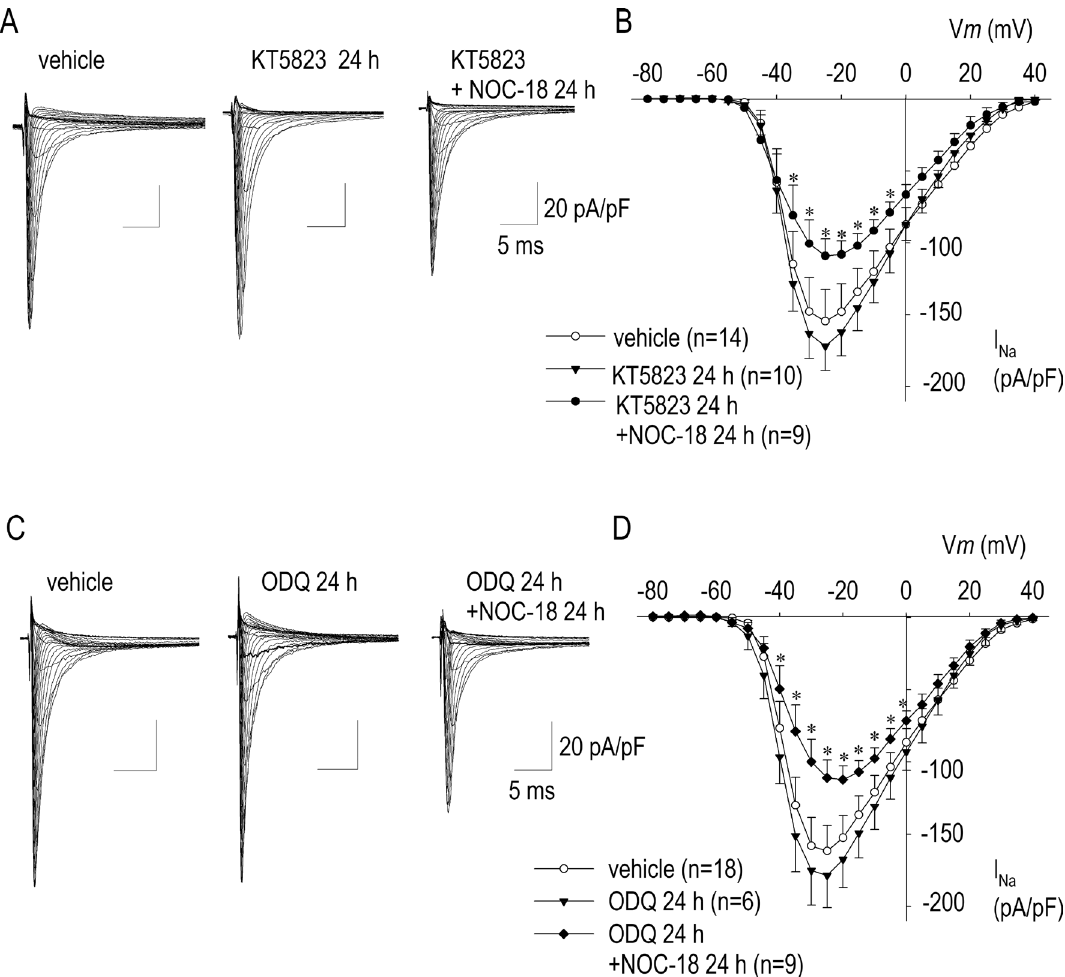
Figure 5. Effects of a PKG inhibitor KT5823 and a guanylate cyclase inhibitor ODQ on NOC-18 for I Na modulation. ( A , B ) Representative I Na traces with 1 mM NOC-18 applied for 24 h in the absence or presence of 500 nM, and their I–V relationships of I Na . In the presence of KT5823, NOC-18 reduce the maximum inward current of I Na by 31%, indicating that I Na inhibiting effects of NOC-18 was independently of the action through PKG. ( C , D ) Representative I Na traces with 1 mM NOC-18 applied for 24 h in the absence or presence of 10 μM ODQ, and their I–V relationships of I Na . In the presence of ODQ, NOC-18 reduced the maximum inward current of I Na by 35%, indicating that I Na inhibiting effects of NOC-18 was independently of the action through GC activity. Numbers of cell are shown in parentheses. Values represent the mean ± SE. * p < 0.05 vs. KT5823 + NOC-18 or vs. ODQ +